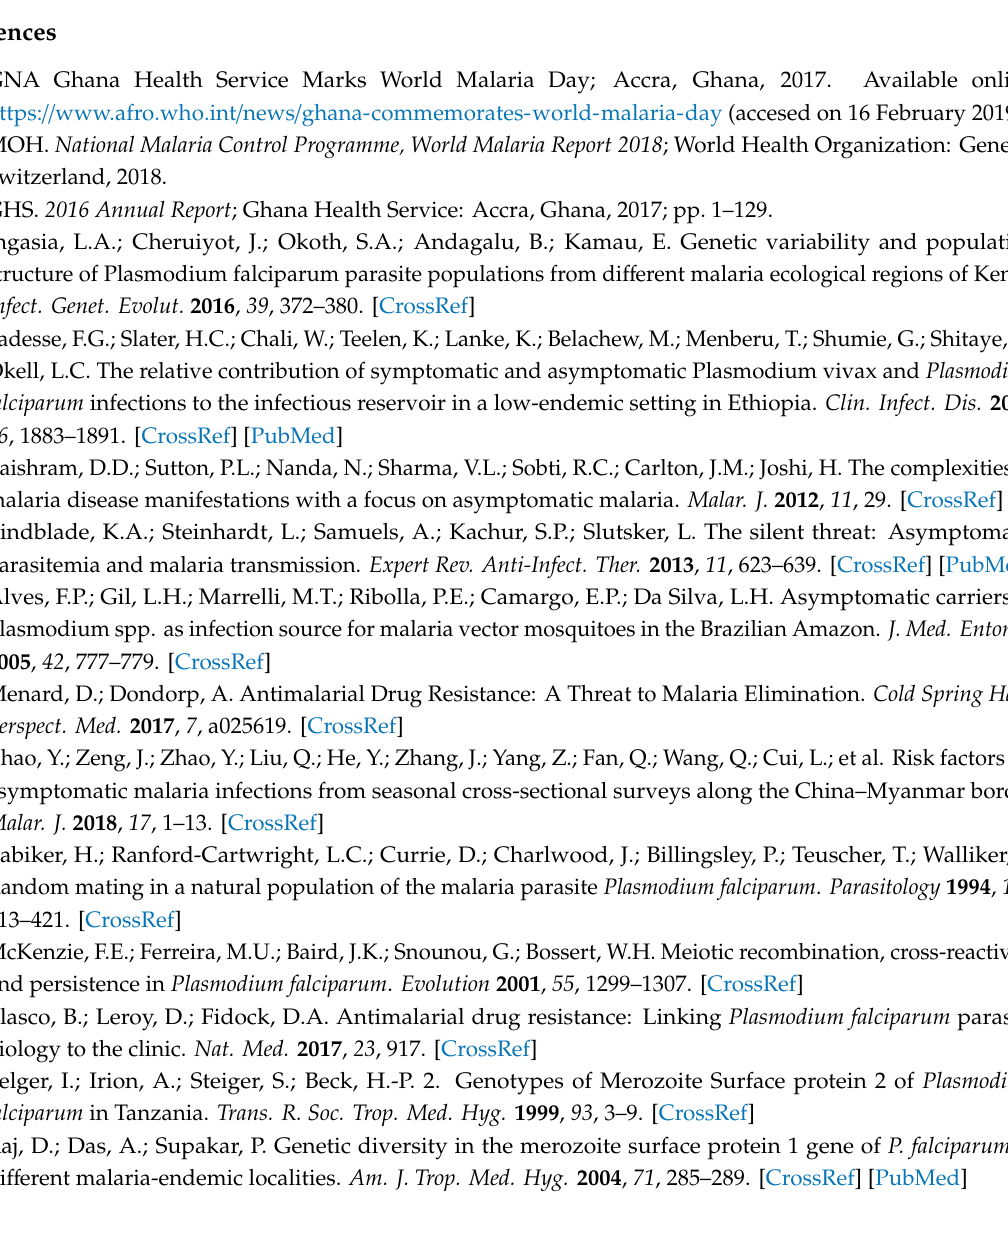
12 microsatellite loci for 51 monoclonal and biclonal samples; Table S4: Binary data of microsatellite alleles among all 60 P. falciparum infected samples from Obom (OB) and Asutsuare (AS). Each allele was coded as presence (1) or absence (0) for each sample. Monoclonal and polyclonal samples were included in the